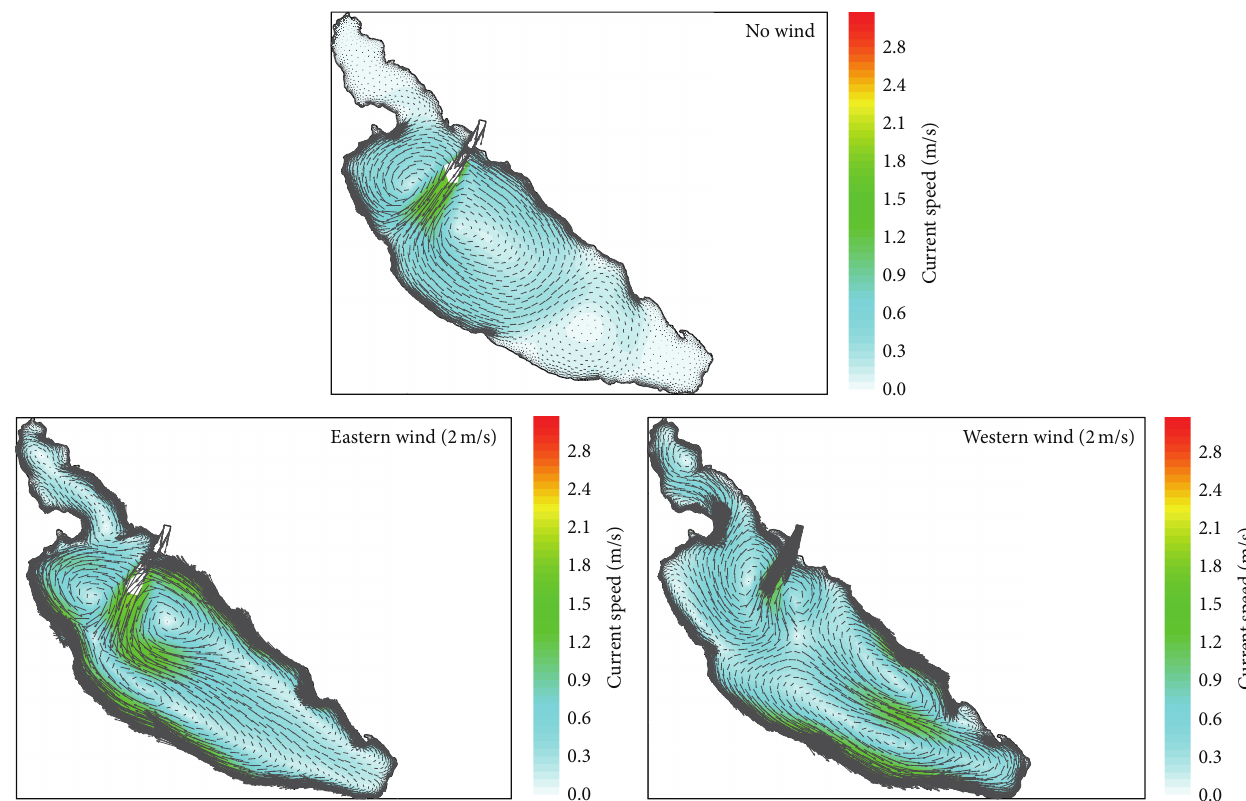
Figure 7: Comparison of velocity fields and magnitudes in Nador lagoon for the wind